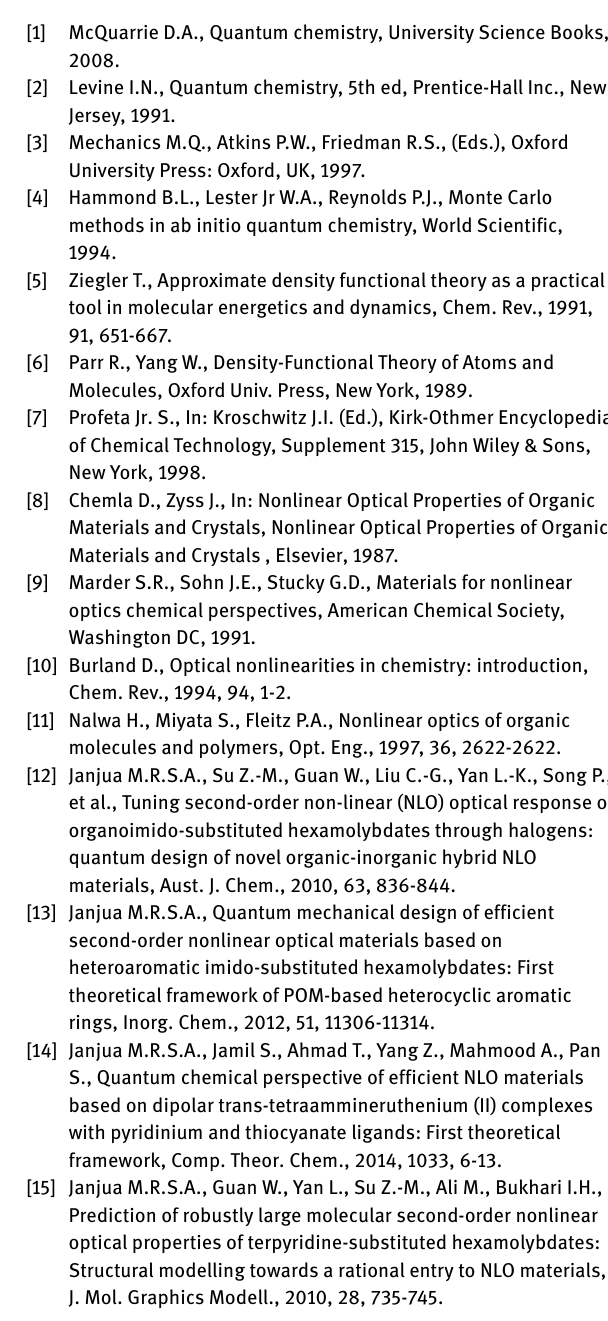
Fi gur e 3: S i mula t ed absorp ti on Spec t ra of dyes (1 - 6) calcula t ed i n gas phase a t D FT/ C AM- B3 L YP / 6 - 31G(d, p) le v el of t